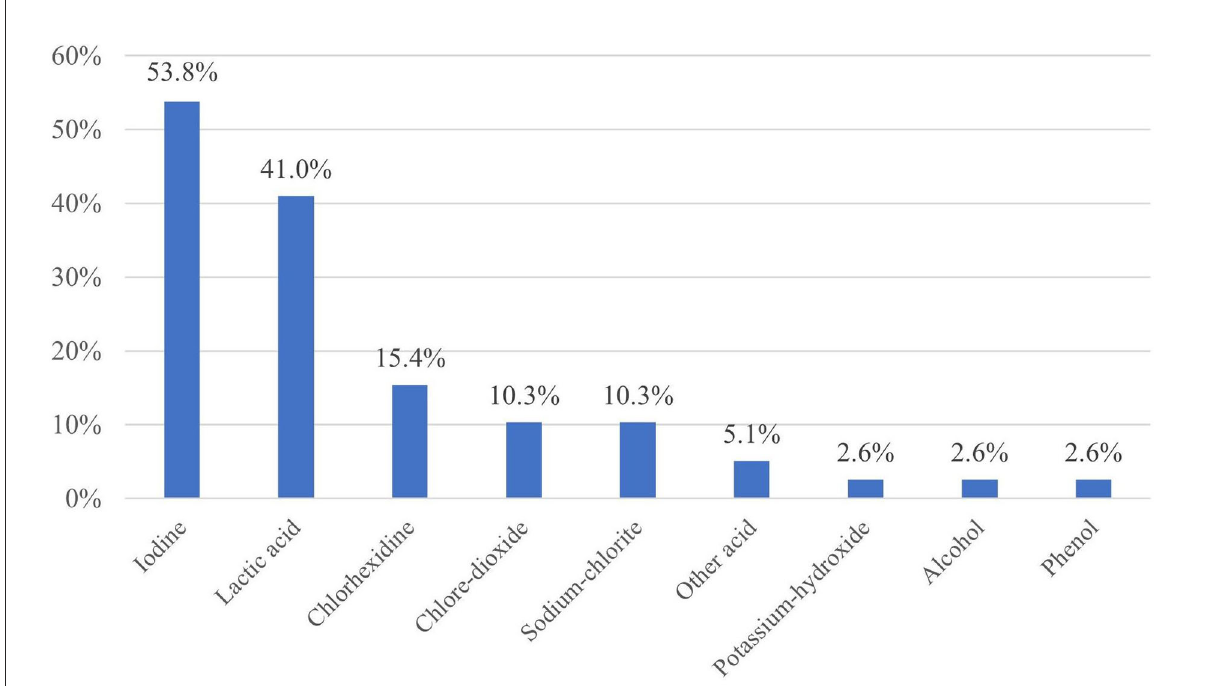
FIGURE2 Active ingredients of the post-milking teat disinfectants ( n = 39).